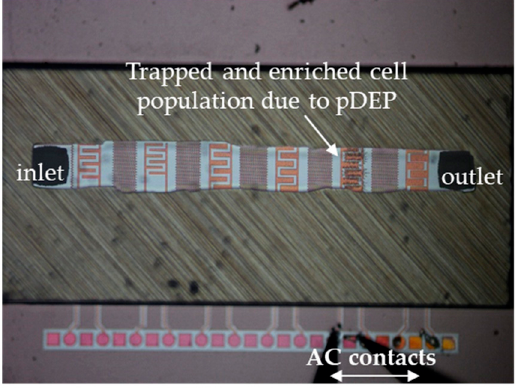
Figure 2. Microfluidic device in operation: cell entrapment at the IDEs after imposing AC and generating DEP.